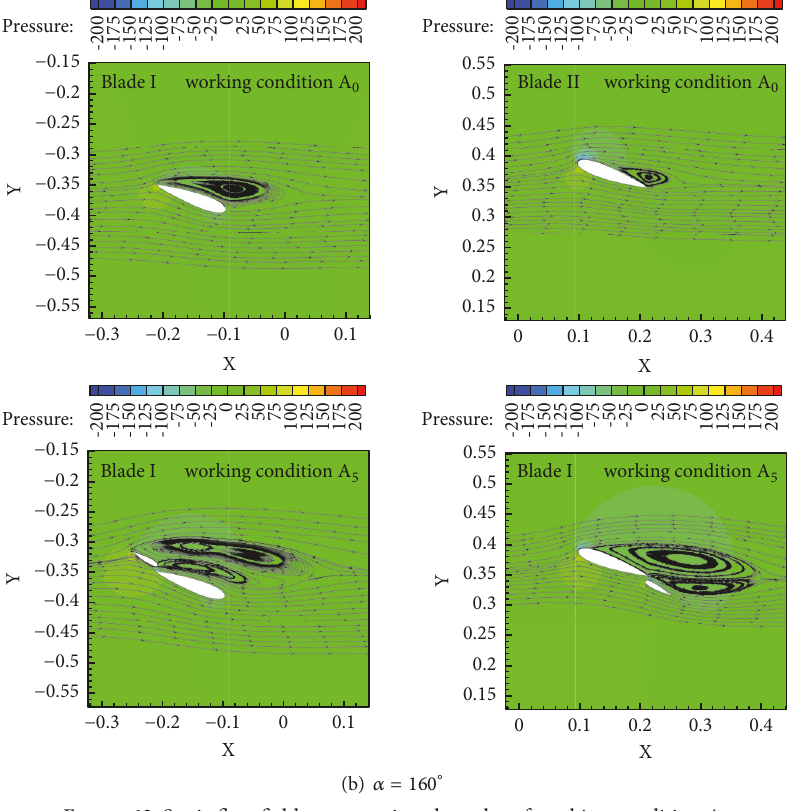
Figure 13: Static flow fields at two azimuth angles of working condition A.